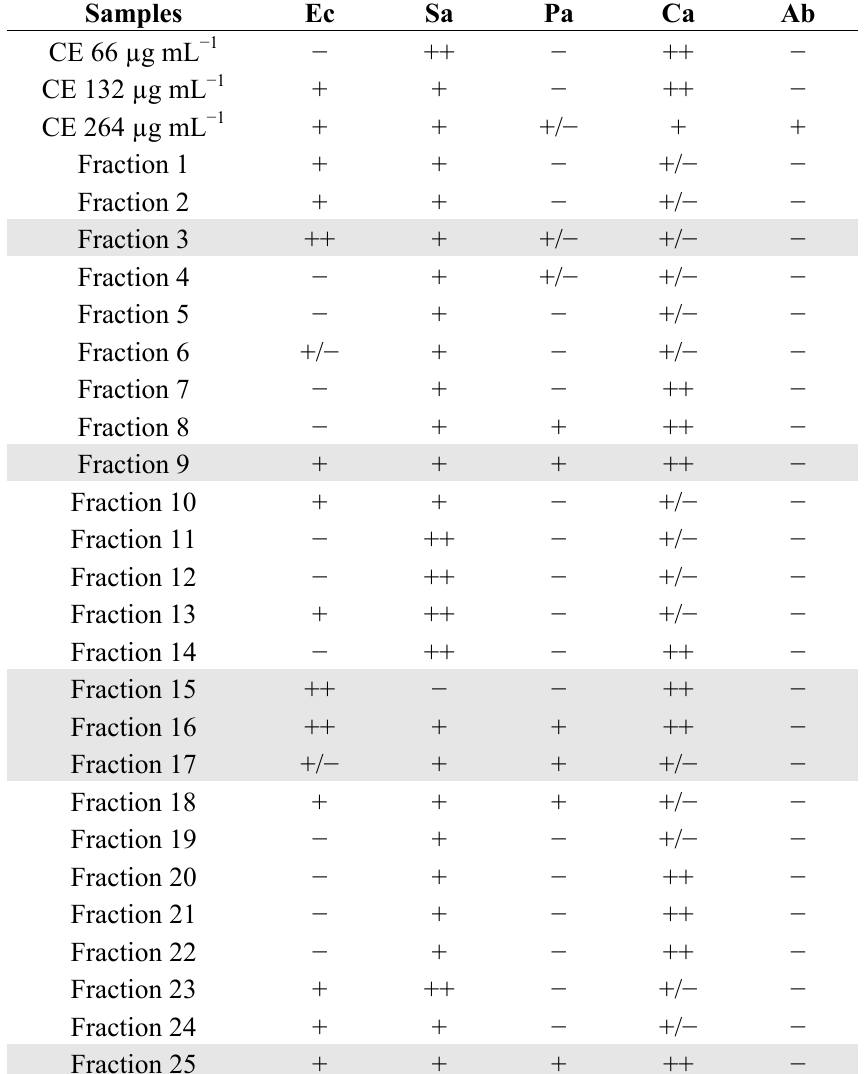
Table 1. Antibacterial activity of Kalanchoe pinnata leaf methanolic crude extract (CE) and fractions obtained by semi-preparative HPLC on Escherichia coli (Ec), Staphylococcus aureus (Sa), Pseudomonas aeruginosa (Pa), Candida albicans (Ca) and Aspergillus brasiliensis